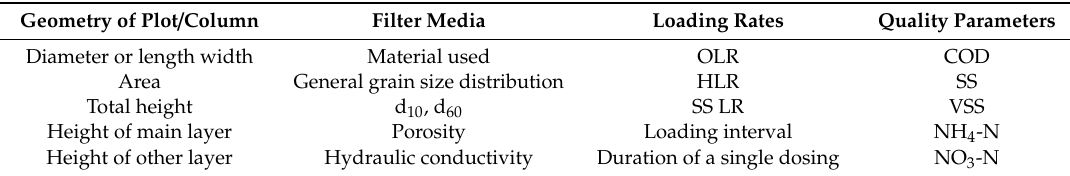
Table 8. Recommendations on information for describing VF wetland experimental